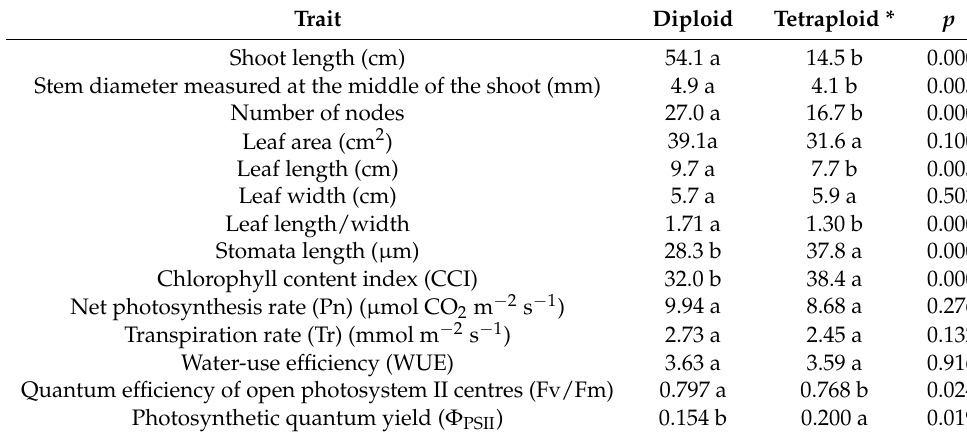
Figure 2. Morphological and physiological parameters of the ‘Free Redstar’ apple diploid and its tetraploid clones evaluated in six-month own-rooted plants; only parameters for significant differences between individual tetraploids were observed are presented: ( A ) leaf/length ratio, ( B ) net photosynthesis-Pn, ( C ) transpiration rate-Tr; means for each trait marked with the same letter do not differ significantly at p = 0.05; Duncan’s test. Table 1. Morphological and physiological differences between diploid and tetraploid six-month old own-rooted plants of ‘Free Redstar’ apple.